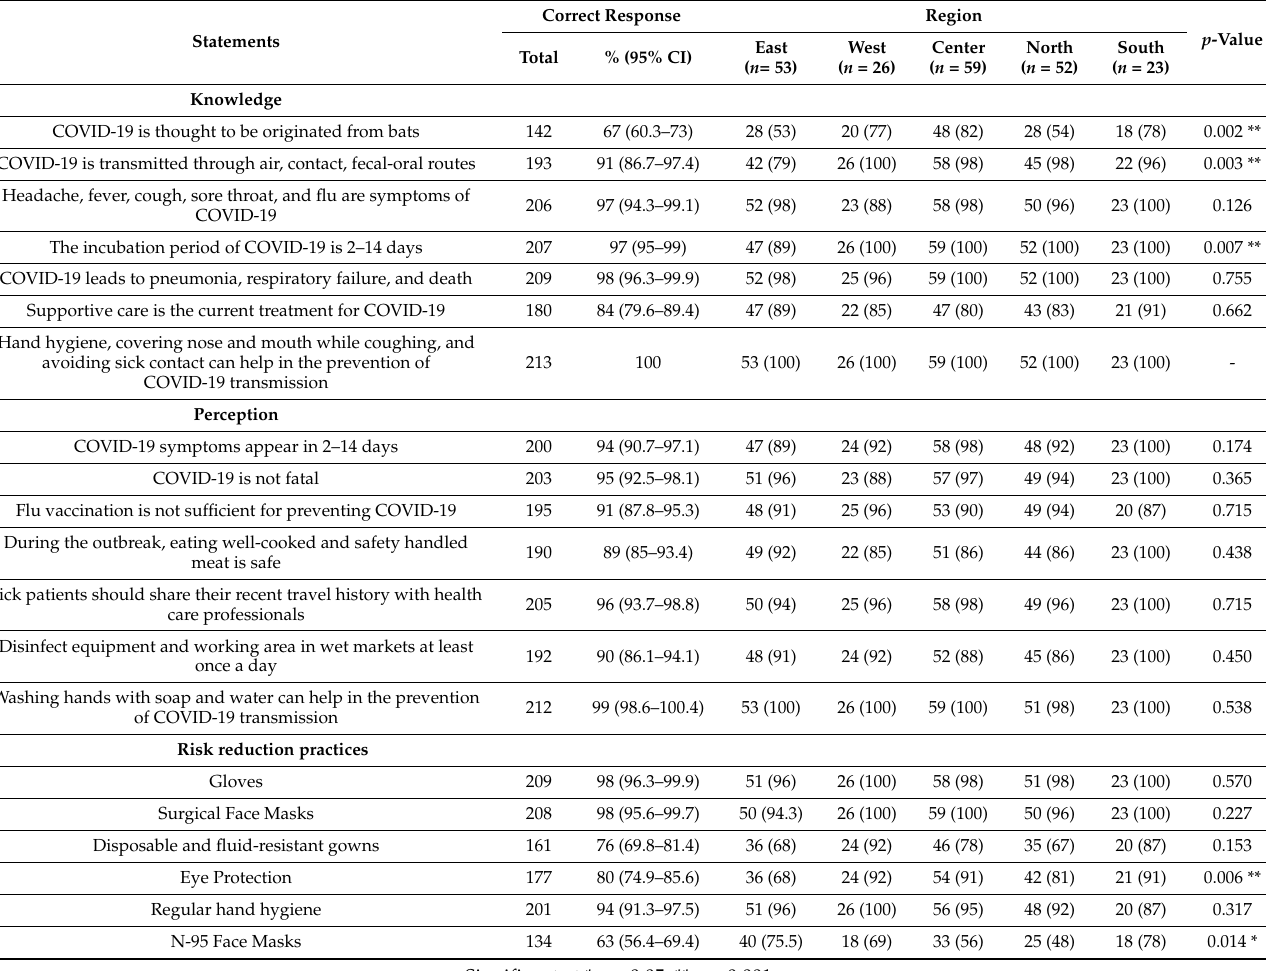
Table 2. Knowledge, perception, and practices related to COVID-19 in healthcare workers in Afghanistan ( n = 213).